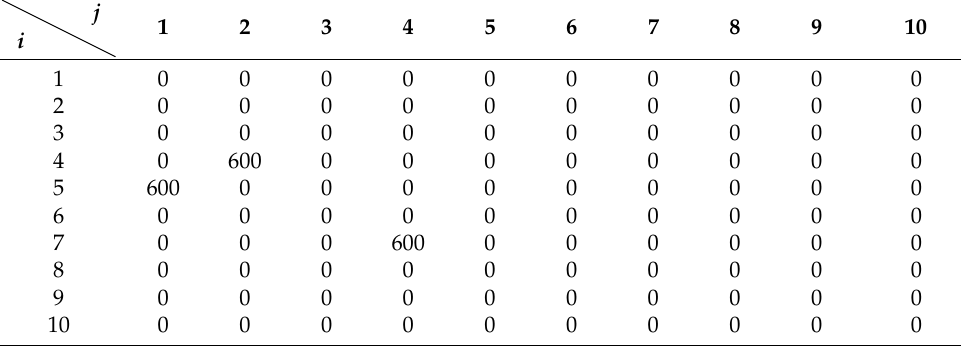
Table 6. The cost matrix ( C ij ) of VSP